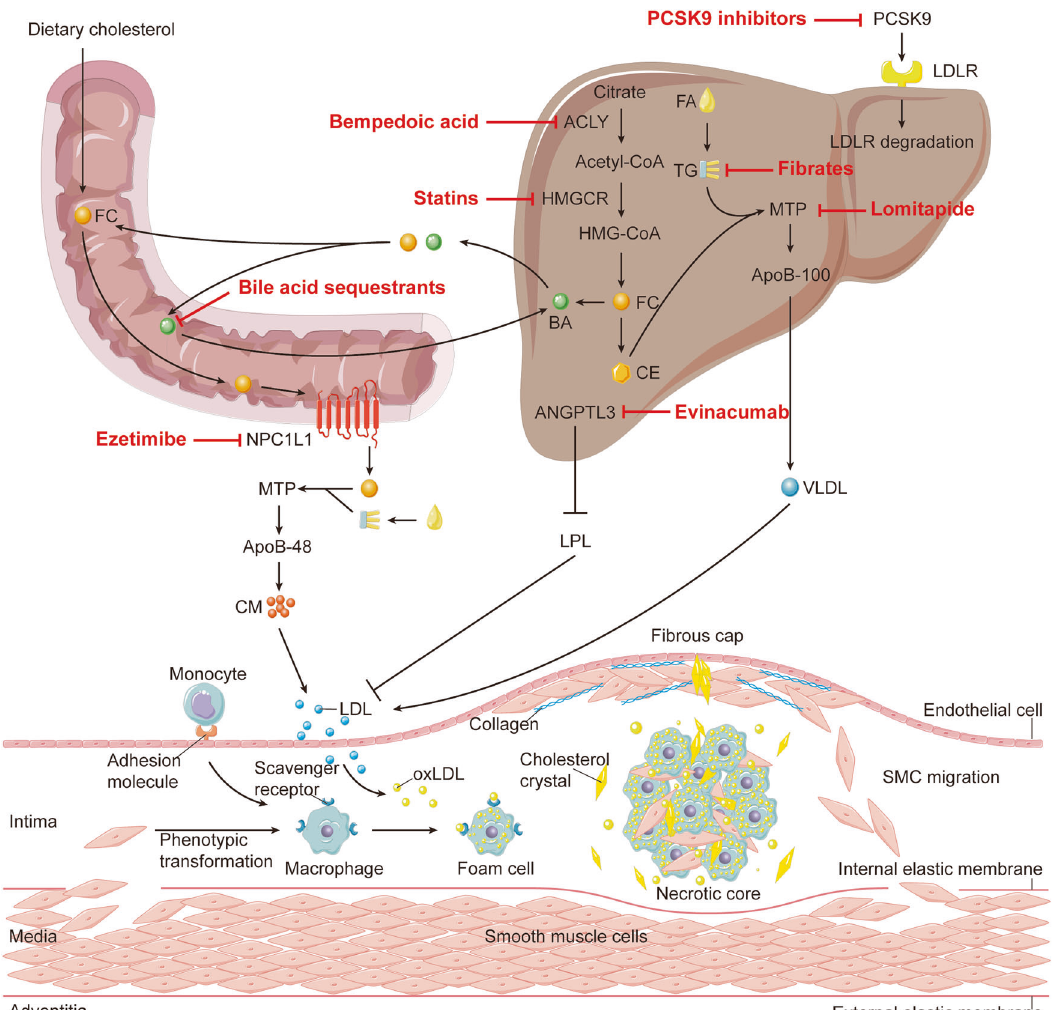
Fig. 4 Inhibition of atherosclerosis by cholesterol-lowering interventions. Bempedoic acid and statins reduce acetyl-CoA and HMG-CoA production by inhibiting ACLY and HMGCR, respectively, thereby lowering cholesterol synthesis. Ezetimibe inhibits intestinal uptake of cholesterol by inhibiting NPC1L1. PCSK9 inhibitors reduce LDLR degradation by inhibiting PCSK9 expression/function. Bile acid sequestrants bind to BA in the small intestine, thus preventing BA from being reabsorbed into the liver. Lomitapide reduces the assembly of ApoB- containing lipoproteins in intestine and liver. Evinacumab restores LPL activity by inhibiting ANGPTL3. Fibrates reduce TG levels. All of the above interventions can reduce plasm LDL-C levels, which is the base for the development of atherosclerosis. The arterial wall consists of three layers: adventitia, media, and intima. The outermost layer, adventitia, is mainly composed of connective tissues. The middle layer, media, consists of smooth muscle cells. The innermost layer, intima, is bounded by endothelial cells (ECs) on the inner side of the lumen and internal elastic membrane on the outer side. Atherosclerotic plaques form in the intima. In the early stage of atherosclerosis, LDL particles enter the intima through EC layer and undergo oxidation and other modi fi cations to form oxLDL, which makes it pro-in fl ammatory and immunogenic. ECs secrete adhesion molecules and chemokines after activation, and monocytes circulating in the blood bind to adhesion molecules and enter the intima under the promotion of chemokines. After entering the intima, the in fi ltrated monocytes then differentiate into macrophages and express scavenger receptors to bind and internalize oxLDL to form foam cells. A subset of smooth muscle cells from the media can also differentiate into a macrophage-like phenotype, which in turn phagocytoses oxLDL to form foam cells. As the lesion progresses, dead foam cells and SMCs aggregate with free lipoprotein and cholesterol crystals in the intima to form a necrotic core. SMCs migrate to endothelium and forms fi brous cap during the evolution of atherosclerotic plaque. As cholesterol crystals grow, they eventually penetrate the intima, causing plaque instability and further rupture of the plaques. Acetyl CoA acetyl coenzyme A, ACLY ATP citrate lyase, ANGPTL3 angiopoietin-like protein 3, BA bile acid, CE cholesteryl ester, CM chylomicron, EC endothelial cell, FA fatty acid, FC free cholesterol, HMGCR 3-hydroxy-3-methylglutaryl coenzyme A reductase, HMG-CoA 3-hydroxy-3-methylglutaryl coenzyme A, LDL low-density lipoprotein, LDLR LDL receptor, LPL lipoprotein lipase, MTP microsomal triglyceride transfer protein, NPC1L1 Niemann-Pick C1 like 1, oxLDL